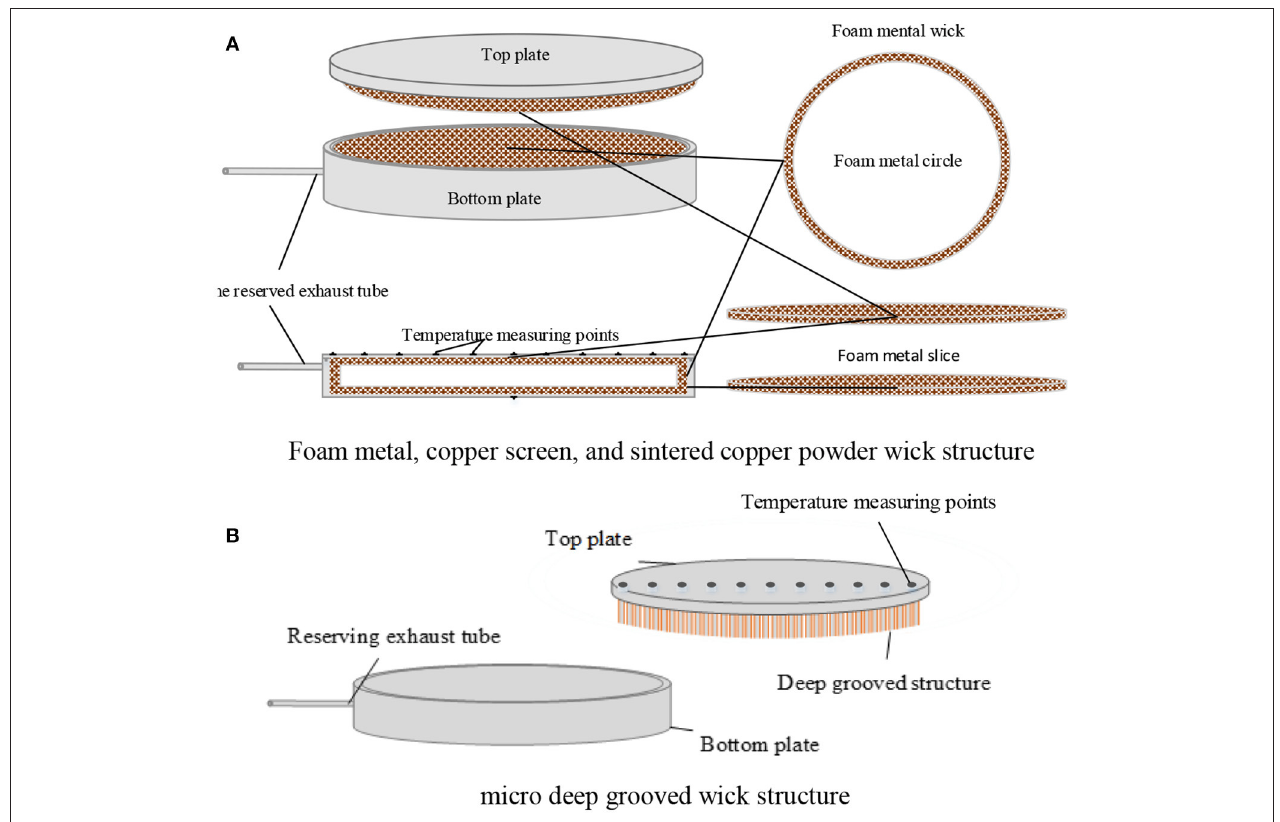
FIGURE 3 | Flat heat pipe block diagram. (A) Foam metal, copper screen, and sintered copper powder wick structure. (B) Micro deep grooved wick